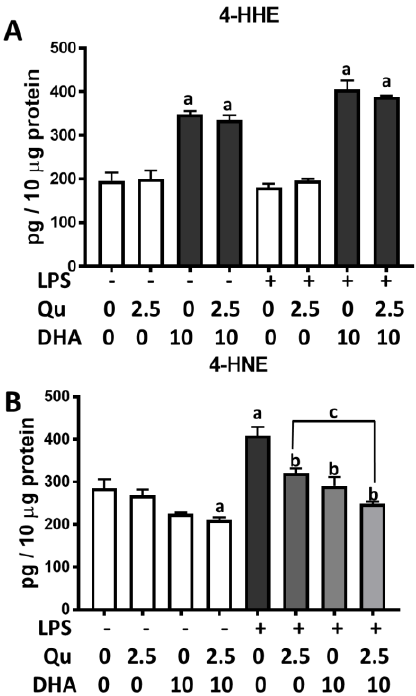
Figure 6. Effects of DHA and/or quercetin on 4-hydroxyhexenal (4-HHE) and 4-hydroxynonenal (4-HNE) levels in microglia cells. Levels of 4-HHE ( A ) and 4-HNE ( B ) upon treatment with DHA and/or quercetin in the presence and absence of LPS (100 ng/mL). “a” represents significant differences ( p < 0.0001) comparing between control versus each treatment. “b” represents significant differences ( p < 0.01) comparing between LPS versus each treatment. “c” represents significant differences ( p < 0.05) between the indicated pairs.